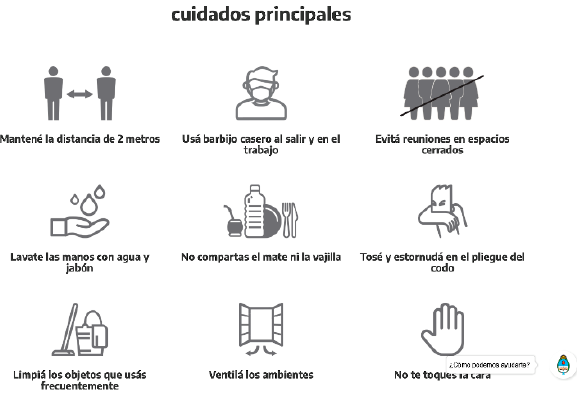
Figure 12. Infographic of COVID-19prevention measures for Argentina’s public [37].